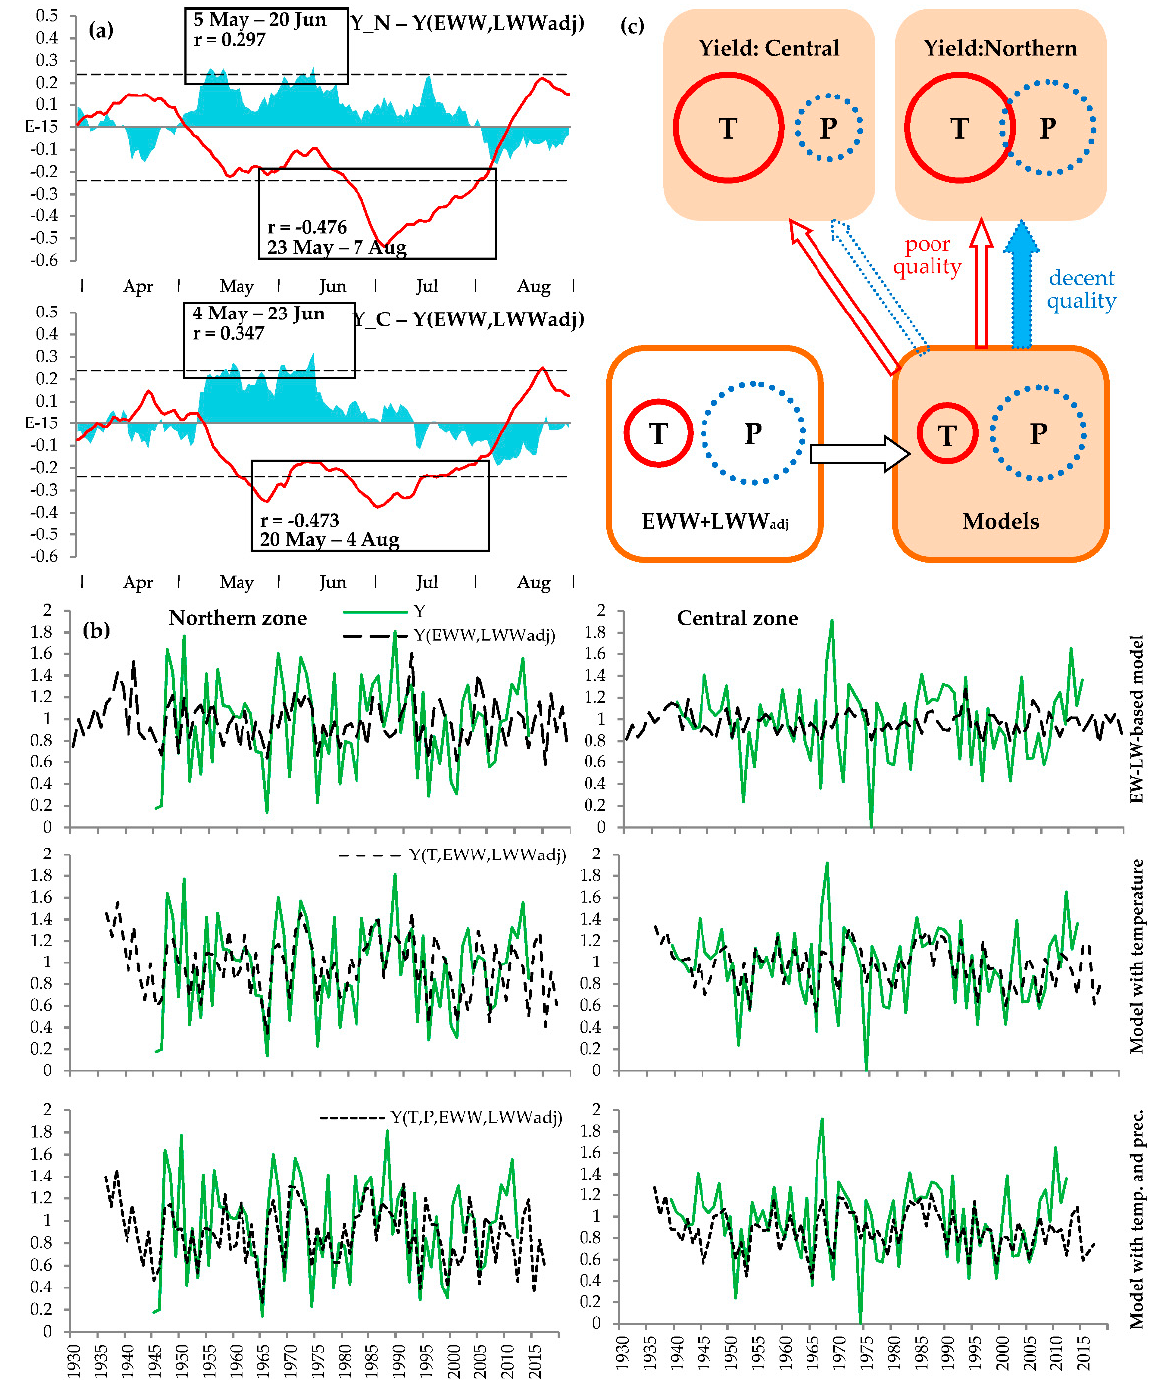
Figure 5. Crops yield modeling. ( a ) Component of the crops yield climatic response not captured by earlywood-latewood-based models: correlations of 21-day moving climatic series with differences between actual yield chronologies and respective models Y(EWW, LWW adj ); rectangles mark periods when climatic factors have maximum correlations with respective yield series. ( b ) Dynamics of the crops yield in Northern and Central zones and its models based on tree-ring parameters alone (top row), on tree-ring parameters and temperature (middle row), and on tree-ring parameters and both climatic factors (bottom row). ( c ) Scheme of developed models’ limitation by difference in signals from growing season temperature and precipitation (bubbles with T and P letters, respectively) registered in tree-ring parameters and crops yield. Bubble sizes indicate relative signal strength.